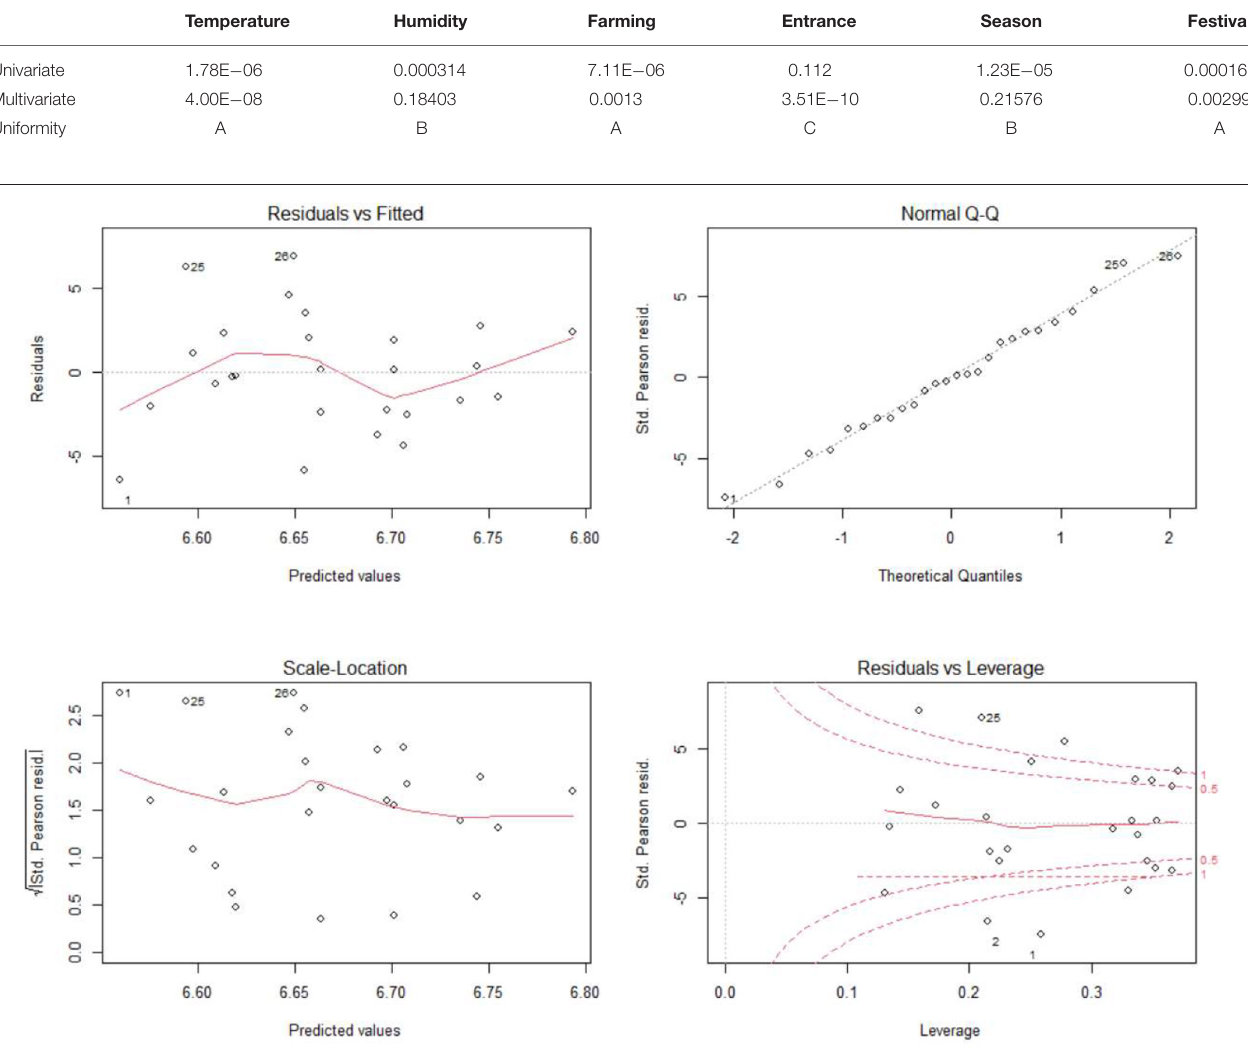
FIGURE 5 | Model verification